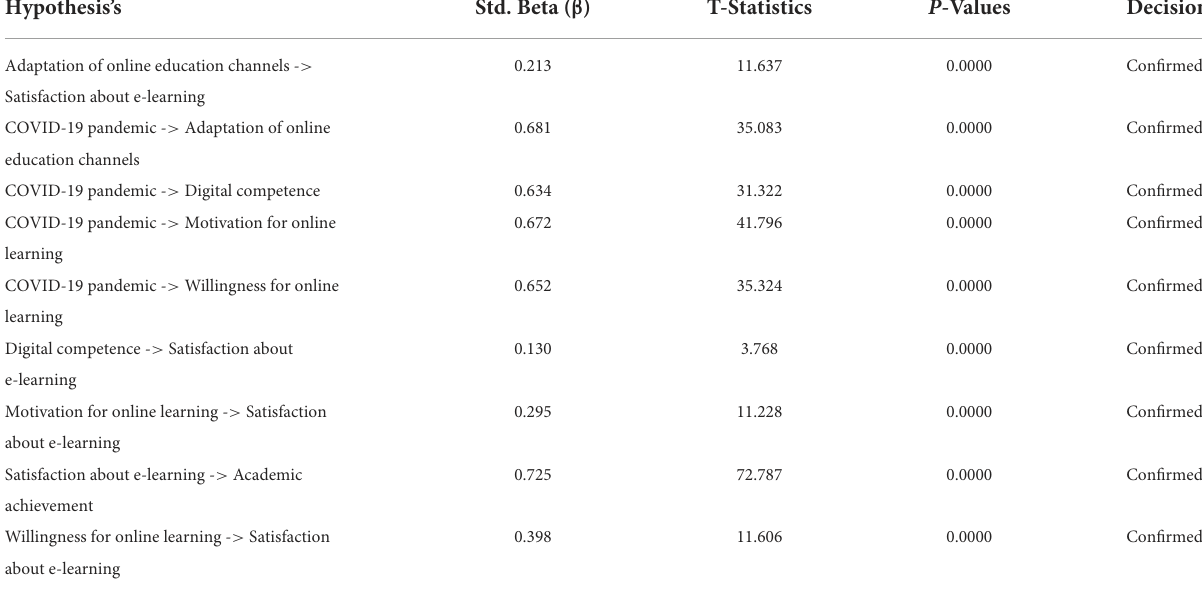
TABLE 5 Final results of standard beta, t-statistics, and p -values (N-1200).